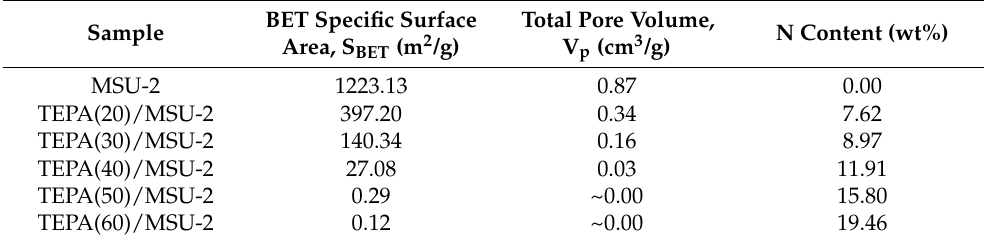
Table 1. Pore characteristics and elemental analysis of unfunctionalized and TEPA-functionalized MSU-2.